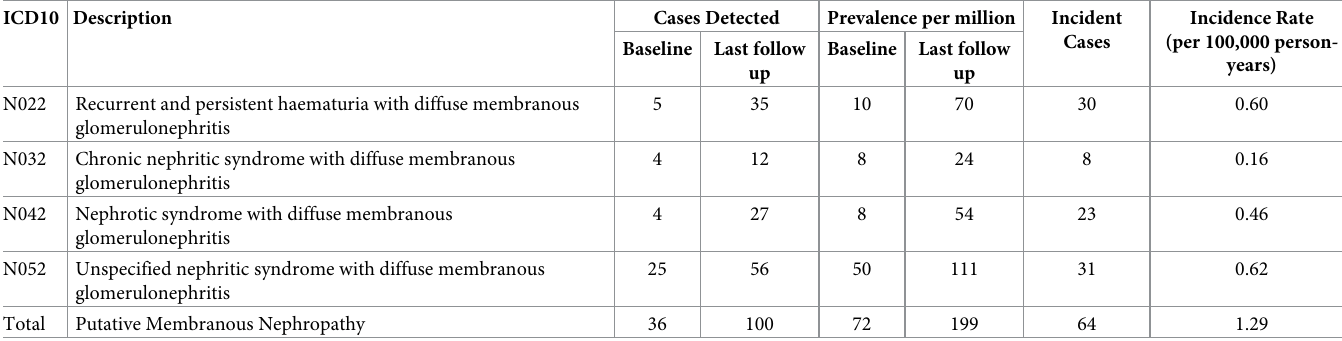
Table 1. Incidence and prevalence.